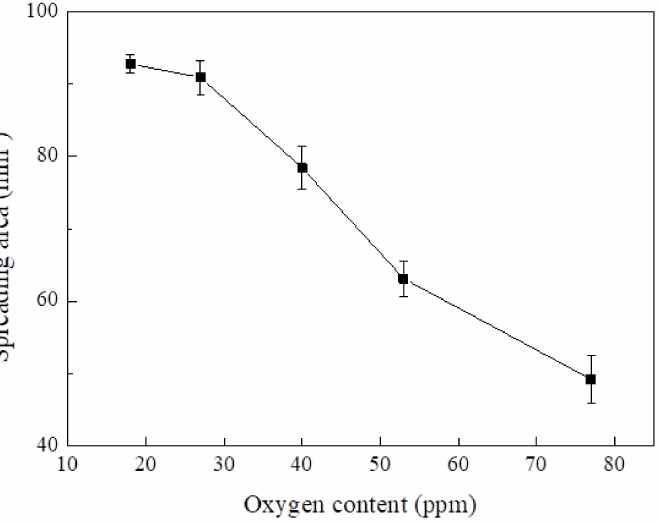
Figure 2. Evolution in spreading area of the Au-20Sn solder on Cu plate with increasing oxygen content in the